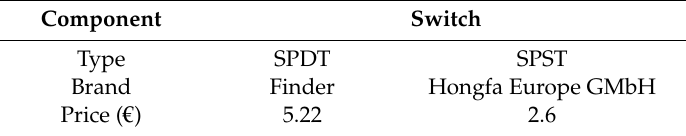
Table 1. Electromechanical relays